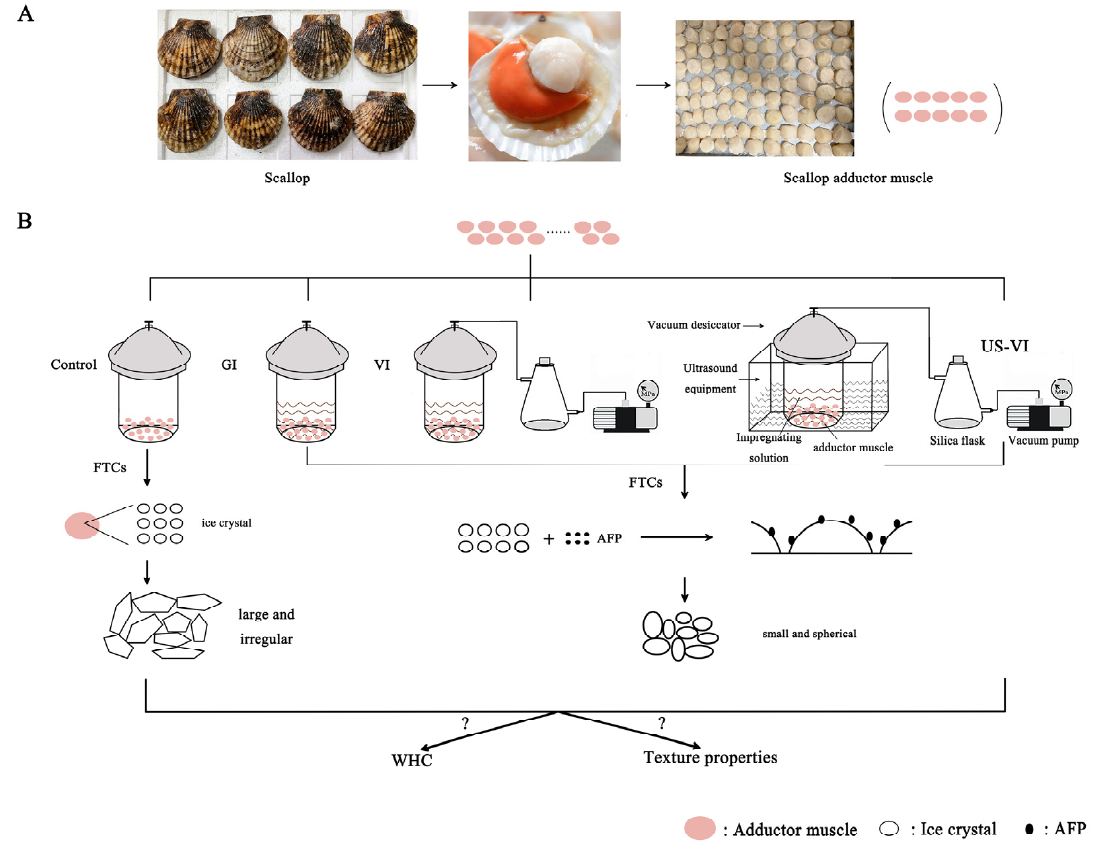
Figure 1. Schematic illustration for the experimental pre-treatment and potential mechanism. ( A ). The pre-treatment process of the experimental sample; ( B ). The Schematic illustration for the potential